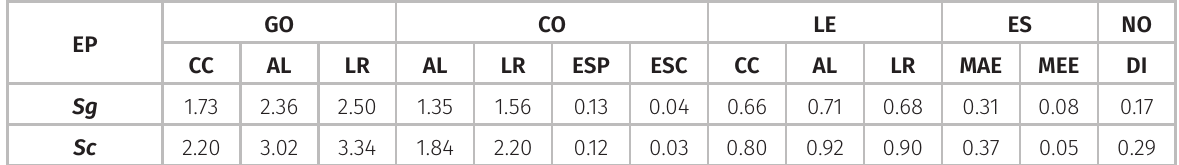
Table III. Morphometry of the eye bulb, in